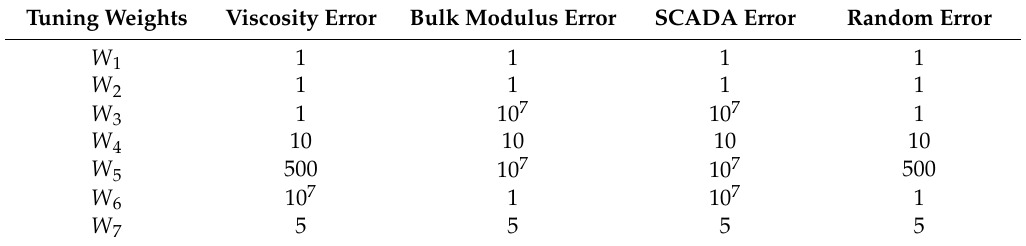
Table 4. Tuning weights in Statefinder for single error and random error scenarios: W j ( j = 1–7) are weights assigned to measured pressure and flow rate, friction, rate of change of pressure, friction, and bulk modulus, and diagnostic flow, respectively. SCADA: supervisory control and data acquisition.